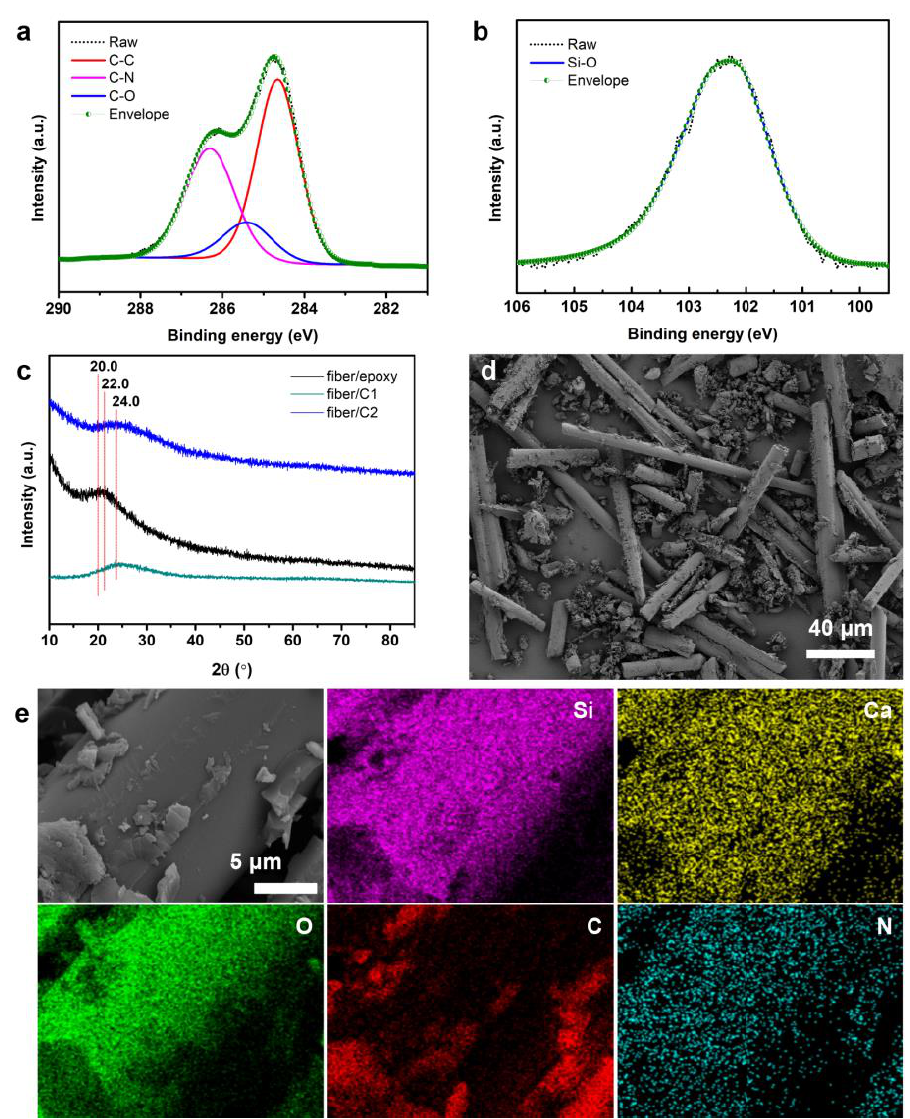
Figure 1. XPS survey spectra of the fibers/epoxy: C 1s ( a ), Si 2p ( b ); XRD spectra of the fibers/epoxy ( c ); SEM image of the fibers/epoxy ( d ); SEM mapping of the fibers/epoxy ( e ). The surface elements of the fibers were mostly O, Si, and Ca, whereas the debris on the glass fiber surface was mostly composed of C and O (Figure 1e), thus indicating that the debris in the fiber/epoxy that was obtained by physical pulverizing was mostly epoxy resin. The O signal in the epoxy resin was visibly weaker than that in the glass fibers, thus suggesting that the O content of the glass fibers was significantly greater than that of the epoxy resin. The physical crushing, however, cannot completely peel the epoxy resin from the glass fiber surface, thus indicating that prior to physical crushing, the epoxy resin and glass fiber were not simply physically bound. The surface modification of glass fiber was helpful for its reaction with the epoxy precursors; this does not occur during the curing process, but with the epoxy precursor during the curing process